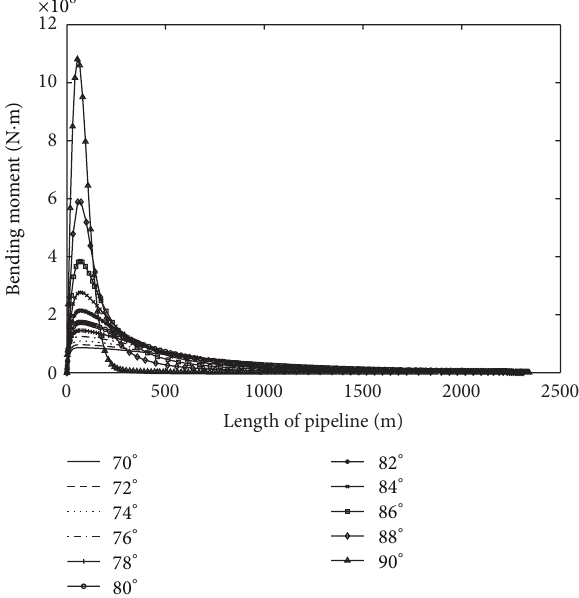
Figure 7: Bending moments of the suspended pipelines in the second